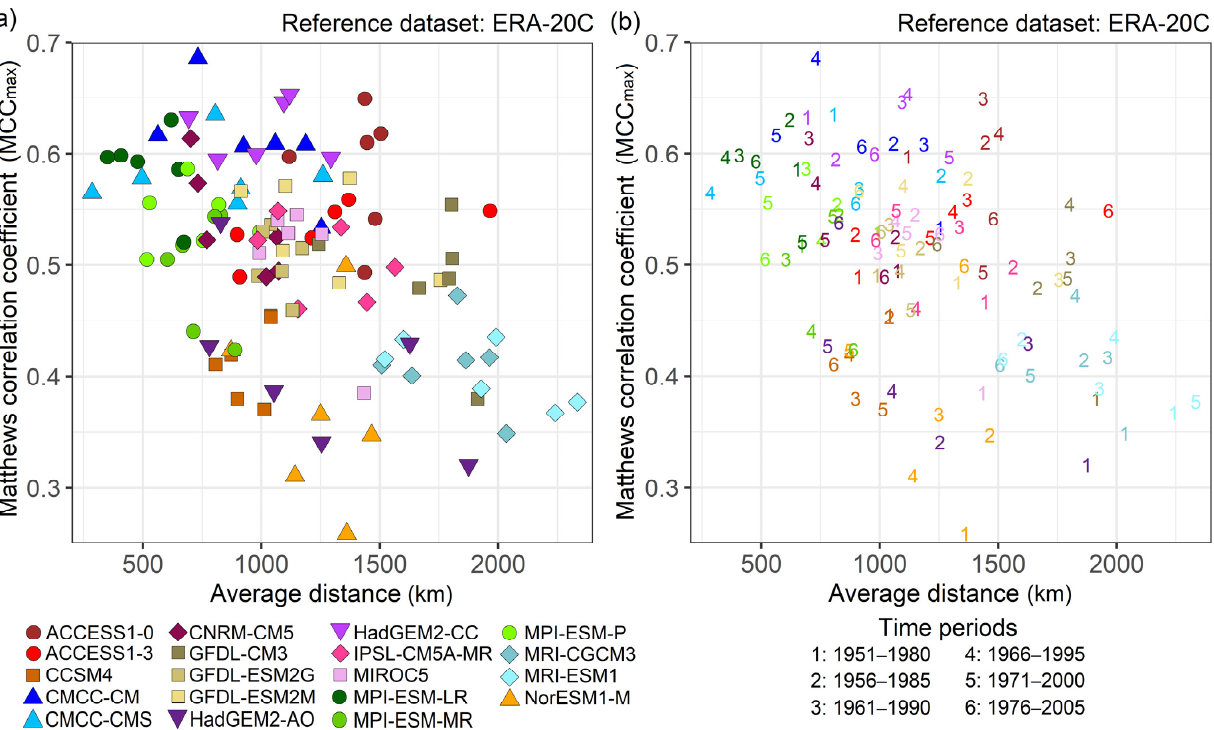
Figure 7. The MCC max values associated with the selected 114 GCM CP maps (plotted in Figure S1 of the Supplementary Material) as the function of the average distances. ( a ) The GCMs are denoted with symbols for better visualization. ( b ) The symbols are replaced with the numbers associated with the examined 30-year-long time periods. The MCC max values and the average distances are available in Table S8 of the Supplementary Material.